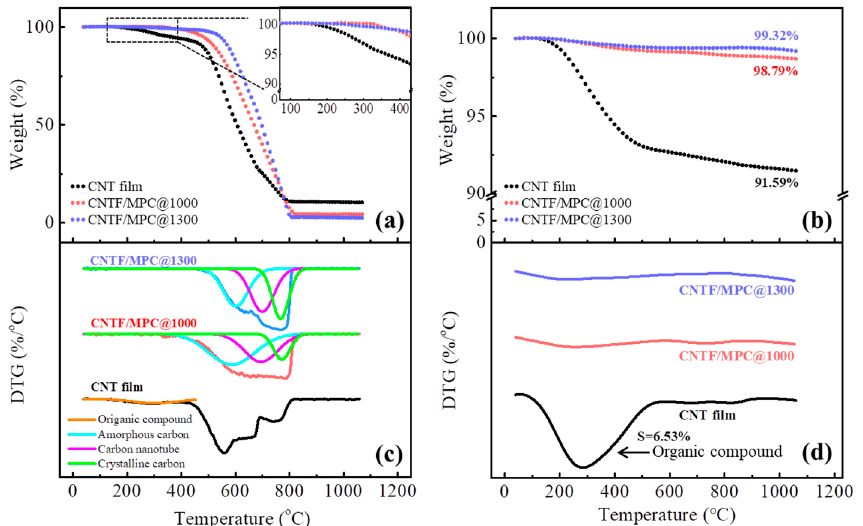
Figure 6. TGA and DTG curves of CNT film, CNTF/MPC@1000, and CNTF/MPC@1300 in air ( a , c ) and in nitrogen ( b , d ).